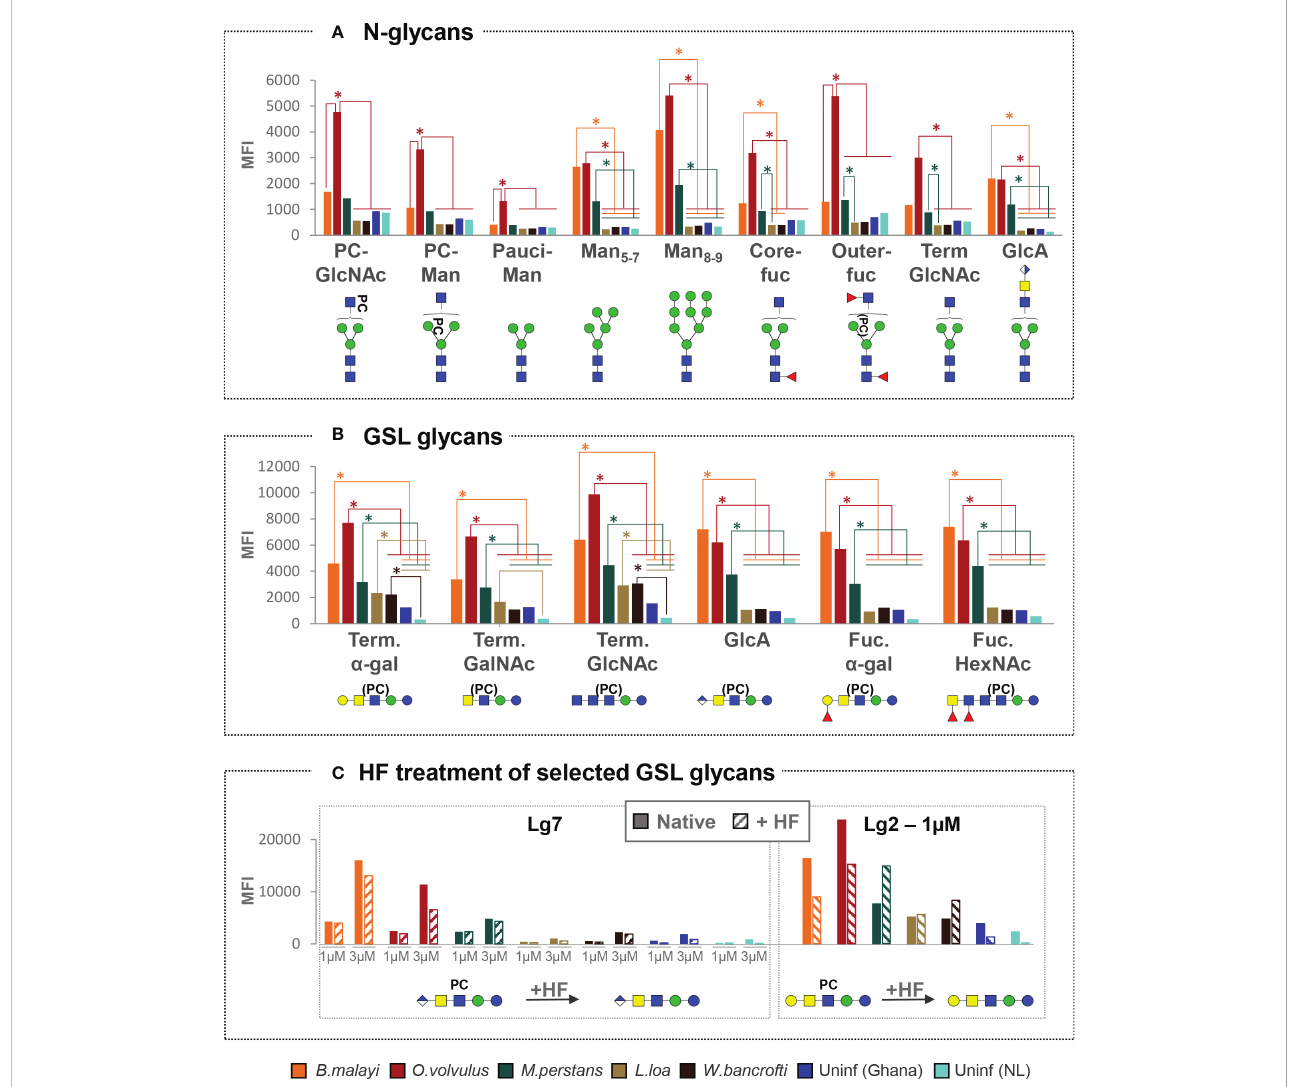
FIGURE 2 Cross-reactivity of IgG in various fi larial infection and control plasmas to B. malayi N-linked and GSL glycan motifs. IgG binding to speci fi c glycan motifs was determined for each individual by averaging MFI values of fractions belonging to the same category based on their glycan contents. Fraction groups are shown on the X-axis and named after the corresponding glycan motif present in the fractions: PC-GlcNAc = PC-substituted GlcNAc, PC-Man = PC- substituted mannose, Pauci-Man = Pauci-mannosidic N-glycans, Man x-y = high-mannosidic N-glycans carrying 5 to 7 or 8 to 9 mannose residues, Core- fuc = a 1-6 core fucosylated N-glycans, Out-fuc = a 1-3 fucose attached to terminal GlcNAc, Term. GlcNAc = Terminal N-acetylglucosamine, GlcA = terminal GlcA, Term. a -Gal = terminal a 1-4 Gal, Term. GalNAc = Terminal N-acetylgalactosamine, Fuc. a -Gal = Fucosylated (terminal) a -1-4 Gal, Fuc- HexNAc = Fucosylated HexNAc(s). A representative glycan structure for each category is shown below the X-axis using the Consortium for Functional Glycomics (CFG) nomenclature (see symbol key inset in Figure 3). MFI values obtained for each category were averaged for individuals from the same infection or control group: B. malayi (n = 10), O. volvulus (n = 6), M. perstans (n = 6), L. loa (n = 6), W. bancrofti (n = 6) infected individuals, uninfected (uninf.) Africans (Ghana, n = 6) and uninfected Europeans (The Netherlands, NL, n = 5). The upper graph shows results for N-glycan categories (A) and the middle graph for GSL glycan categories (B) . Statistical differences between groups were assessed using Bayesian statistics and obtained p -values can be found in Table S3. Signi fi cant differences (with threshold of signi fi cance a = 0.05) are represented on the graphs using asterisks and connecting lines. The lower graphs (C) compare the averaged MFI values for selected native or HF treated GSL fractions, i.e. with or without PC substituents as illustrated below the x-axis, where structures contained in the corresponding fractions are